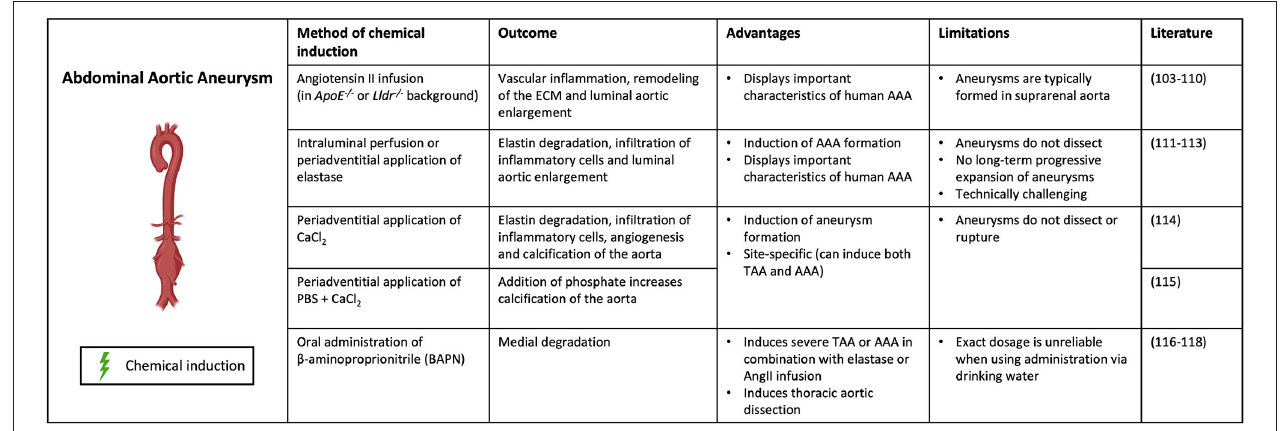
FIGURE 3 | Contemporary murine models for AAA. Abdominal aortic aneurysm can be modeled through chemical induction using Angiotensin II (in ApoE − / − and Lldr − / − mice), elastase, calcium chloride [CaCl 2 , with/without phosphate (PBS)] and β -aminoproprionitrile (BAPN). (Picture created with